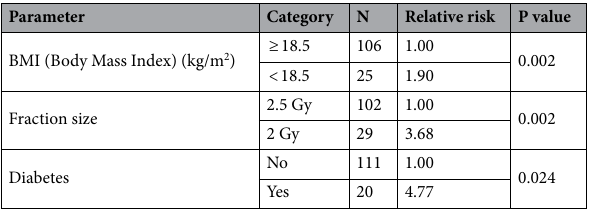
Table 4. The results of multivariate analysis of correlations between selected prognostic factors and local control.